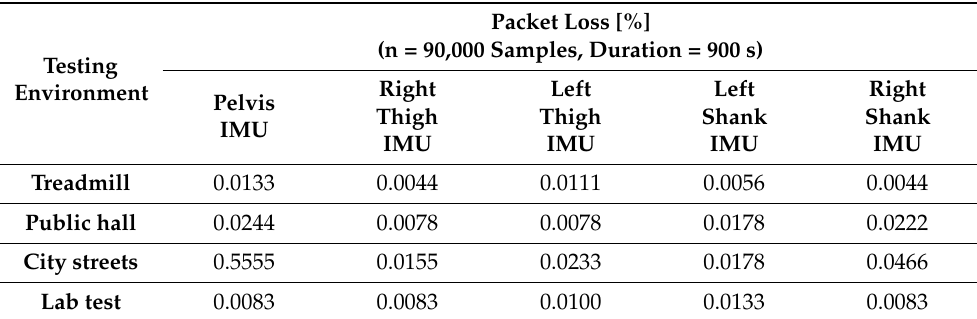
Table 2. Packet loss is measured between the five IMU units and the master unit while a person is